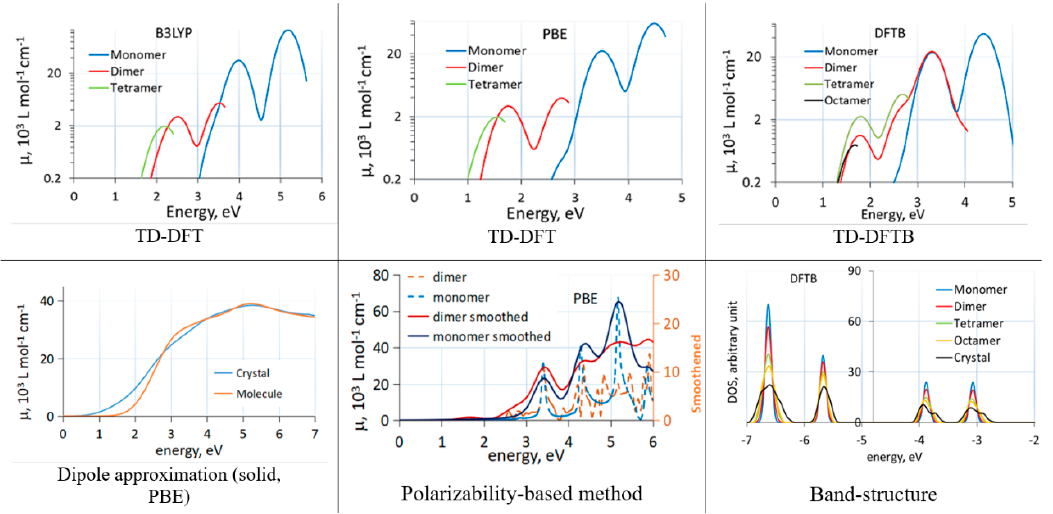
Figure 1. Absorption spectra of C60 clusters (TD-DFT(B) and polarizability-based method) and solid (dipole approximation) computed with different methods. TD-DFT(B) curves end due to a finite number of excited states. The bottom right panel shows changes to the bandstructure induced by aggregation. Reproduced from [43] with the permission of AIP Publishing.